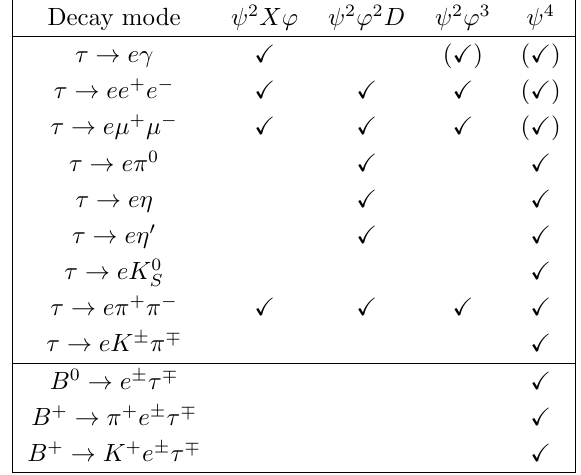
Table 10 . Illustration of the contributions from six different types of gauge-invariant CLFV oper- ators to low-energy decay modes. The parentheses imply that the operator induces the decay only at 1- or 2-loop